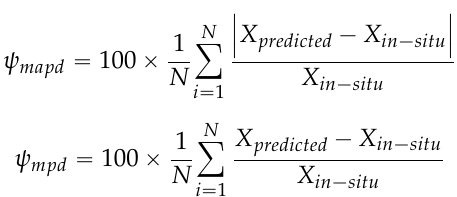
Figure 3. FUI colours derived from MERIS full-resolution imagery captured on 2 May 2009. Image was generated using the online marine data analyser [36].